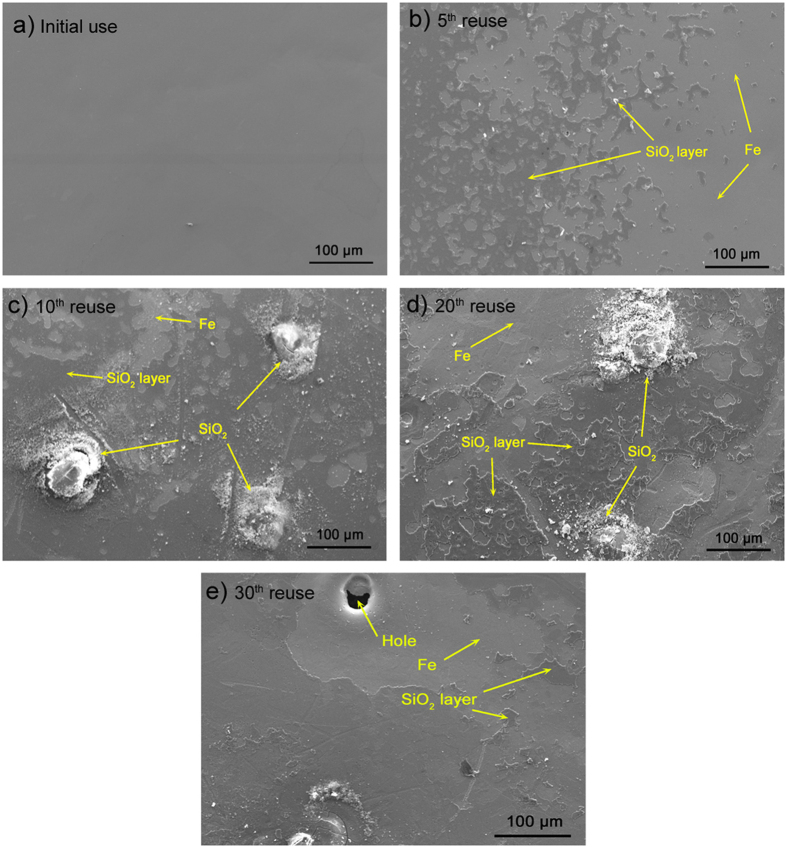
SEM micrographs of (a) fresh use, (b) 5th use, (c) 10th use, (d) 20th use and (e) 30th use of Fe78Si9B13 ribbons.